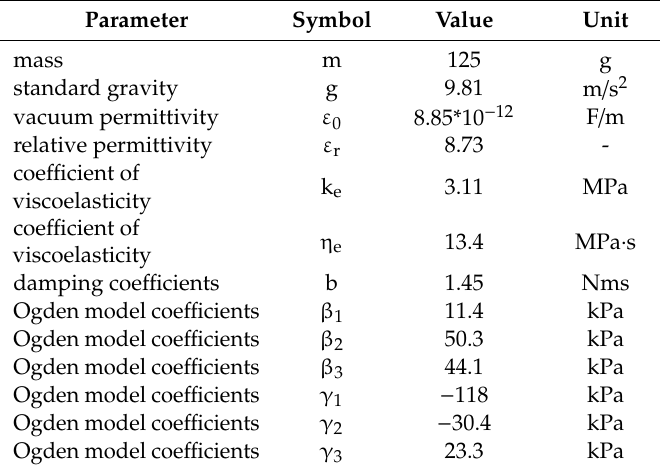
Table 1. DEAP actuator model